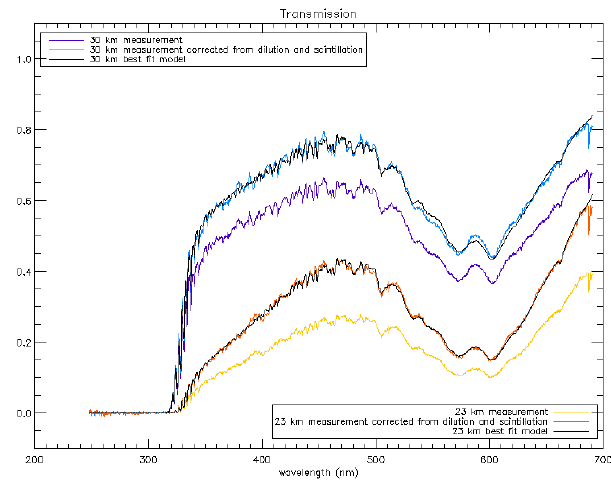
Fig. 21. Examples of transmissions measured at 23 and 30 km. The Level 1b measurements are in yellow and violet for 23 and 30 km, respectively. They are shown in red and blue after correction for dilution and scintillations, while the best fit models of the transmission are shown in black.